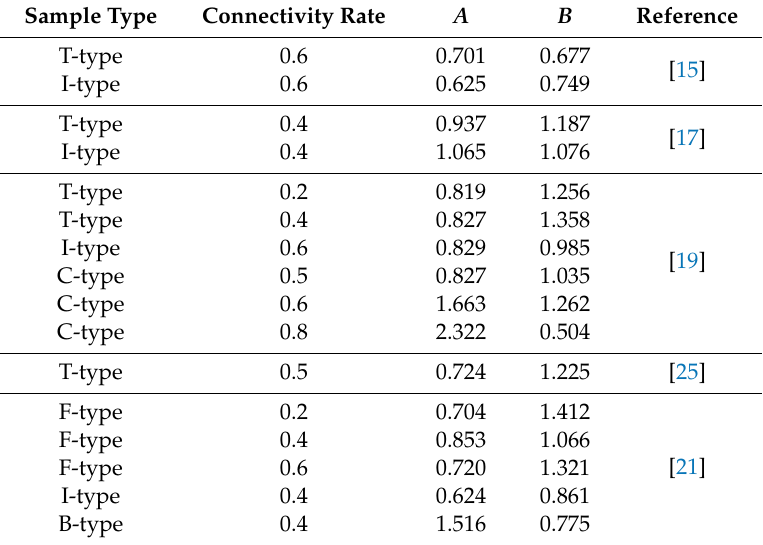
Table 3. Correction coefficients A and B of the strength parameters for rock mass samples with various discontinuity positions and connectivity rates.